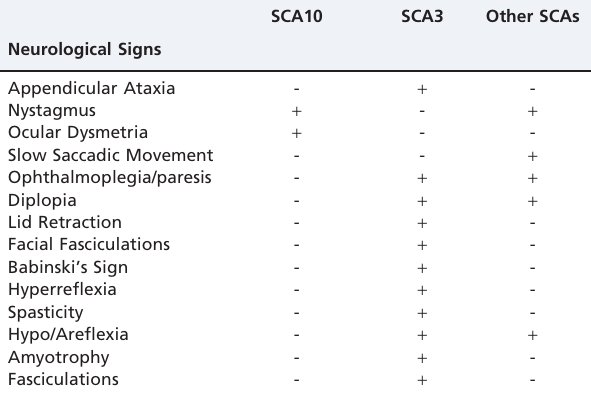
Table 3 - The neurological signs most commonly identified in patients with SCA10, SCA3, or other types